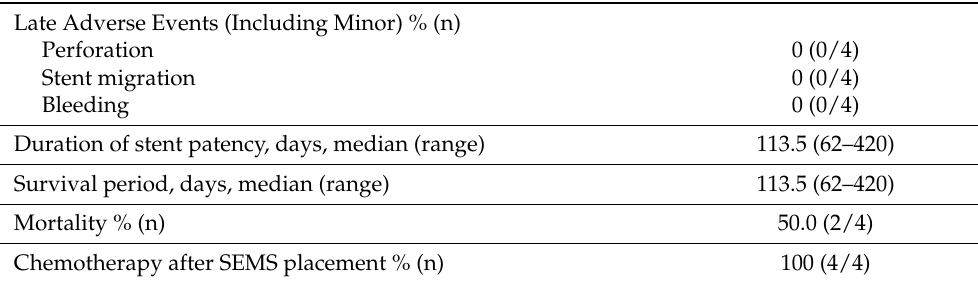
Table 4. Long-term outcomes in the PAL